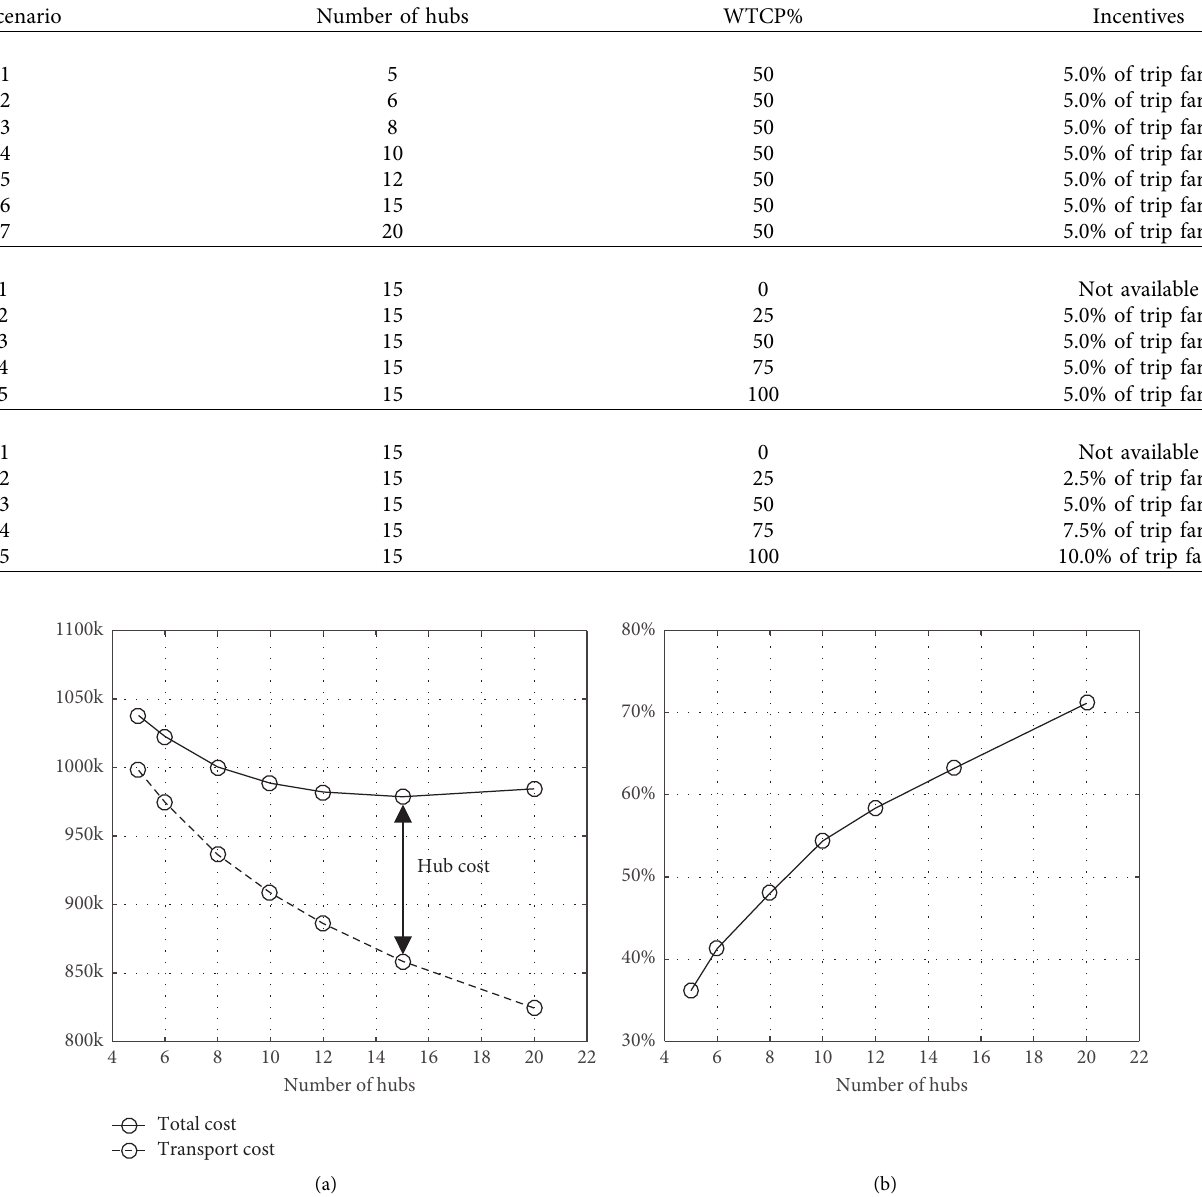
Figure 4: Spatial distribution of taxi trips (source: authors’ revision based on the data provided by Shanghai Qiangsheng Taxi). (a) Taxi flow distribution: outgoing and (b) taxi flow distribution: Table 4: Design of the scenarios.